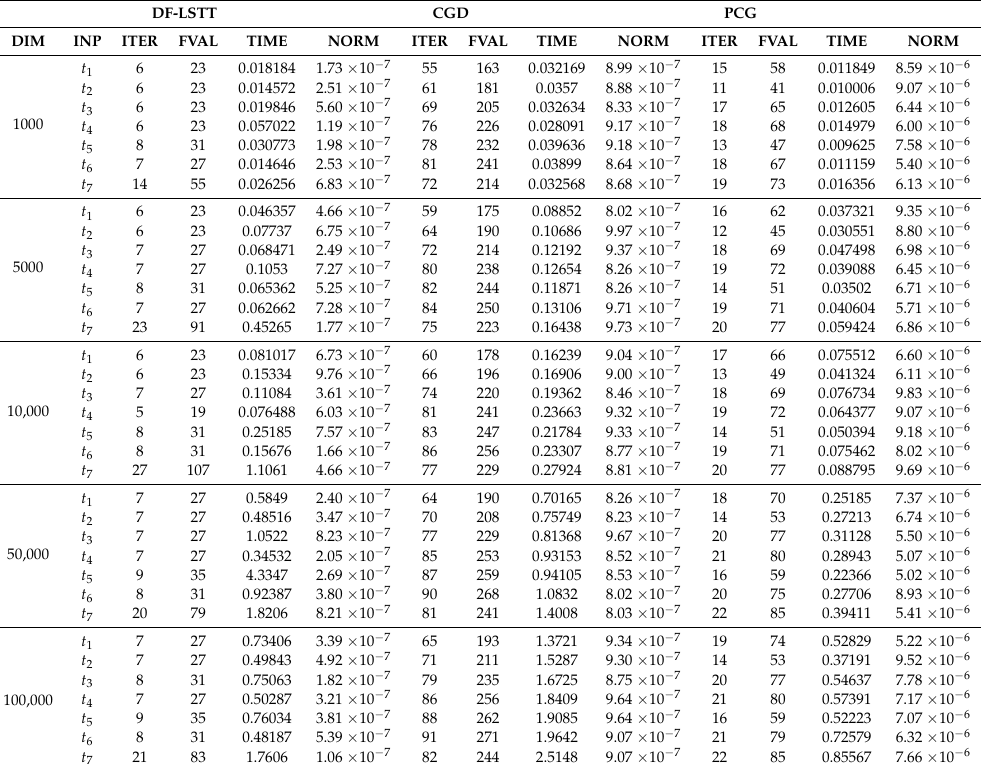
Table 4. Numerical test reports for the three tested methods for Problem 2.